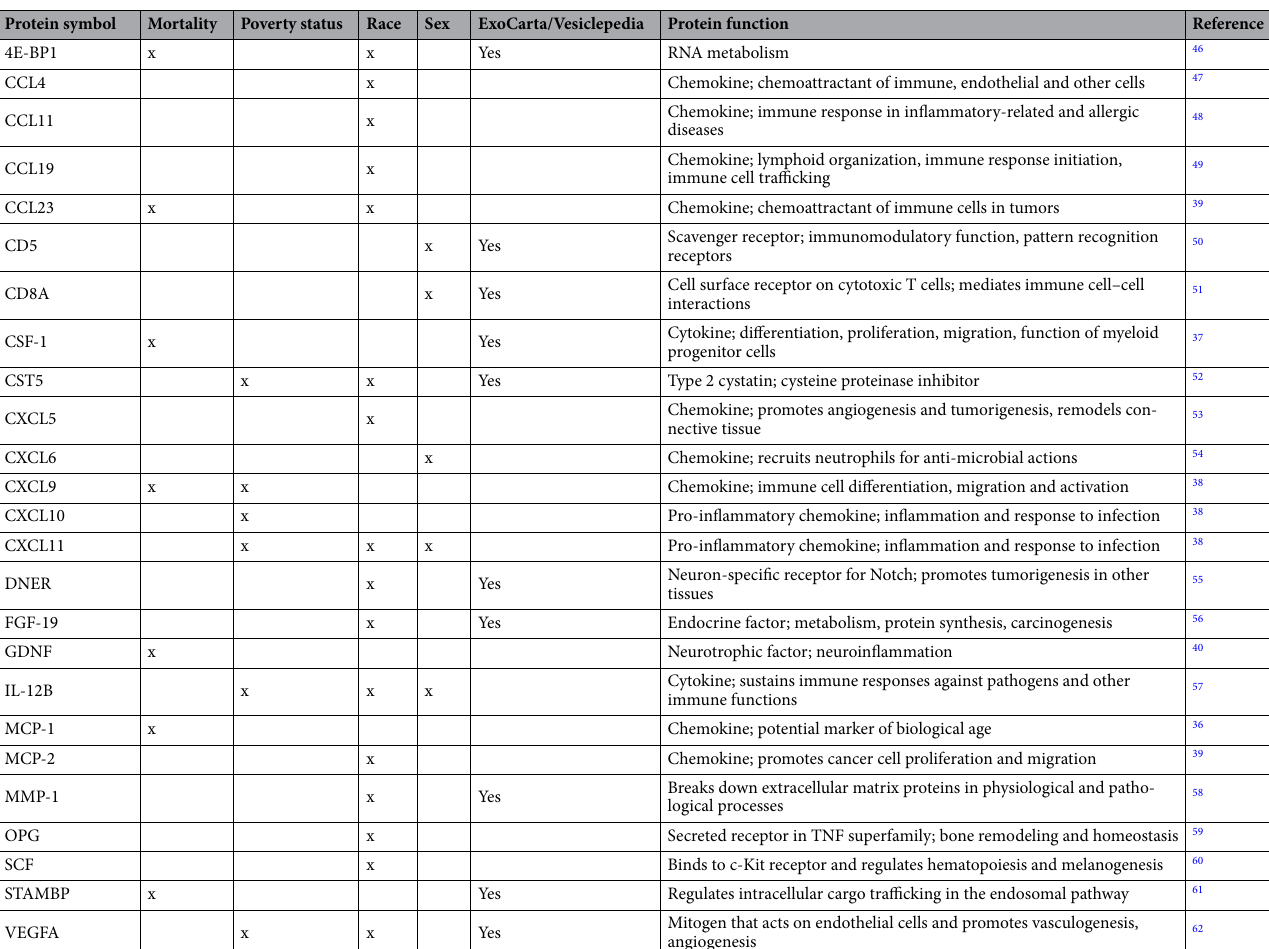
Table 2. EV inflammatory proteins significantly associated with mortality, poverty status, race, and sex. Proteins significantly associated with mortality, poverty status, race, and sex were determined from linear regressions and indicated with an X in the columns. Proteins reported to be present in EVs in databases (ExoCarta and Vesiclepedia) are indicated with a “yes”. General functions of proteins are listed, not necessarily functions attributed to these proteins in